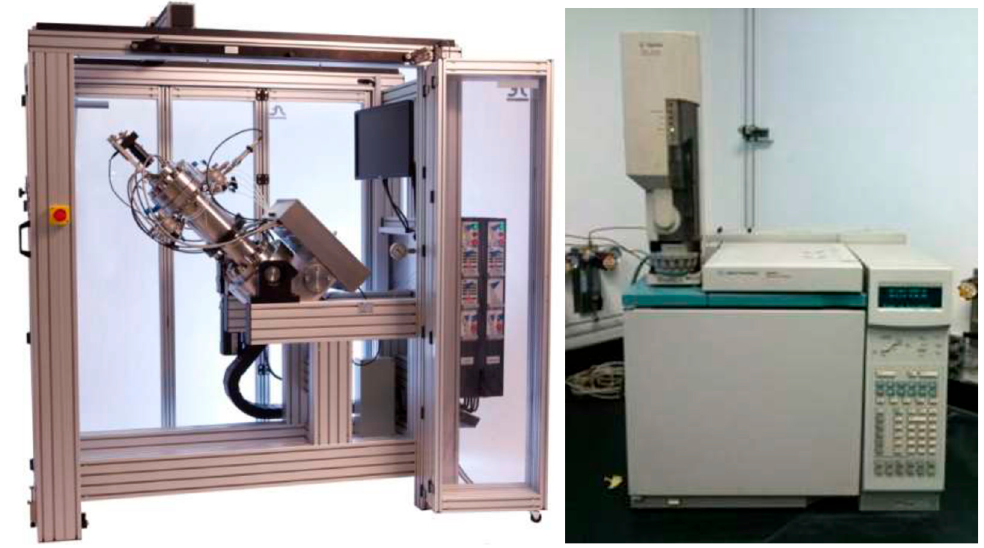
Figure 1. Device diagram of flash separation experiments.